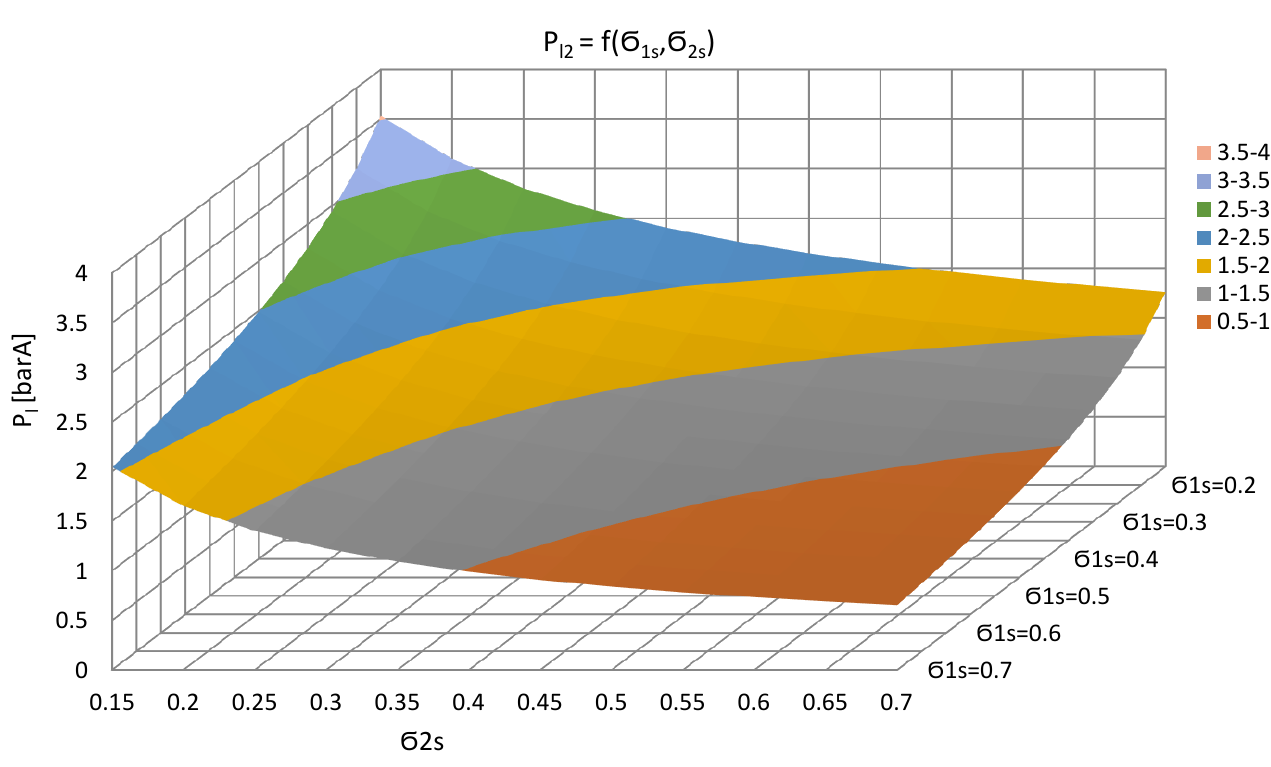
Figure 7. Relation of the steam pressure on the outlet from the two-stage injector unit driven by steam bleads 6.6 and 10 barA in the function of the ejection ratio P l 2 = f ( σ 1 s , σ 2 s ) .